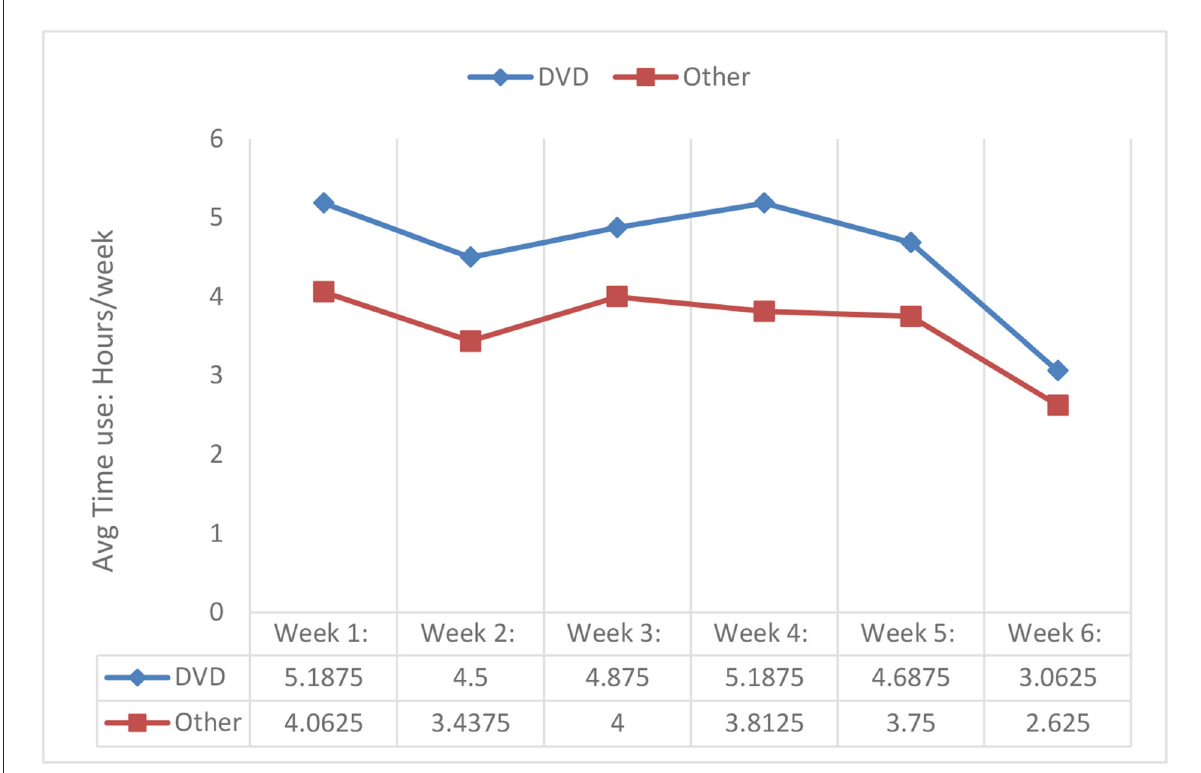
FIGURE2 Adherence to the DVD-HEP and other activities ( n = 14)*. *Data from two participants were